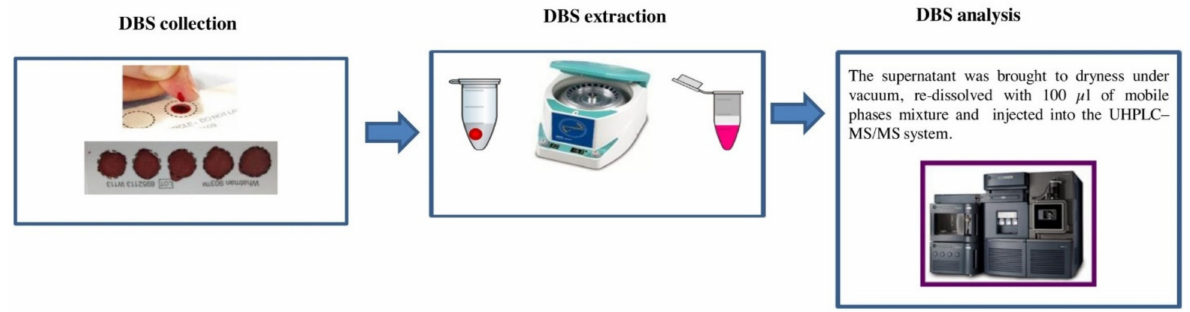
Figure 18. The procedure of dried blood spot analysis (reproduced with permission from Elsevier